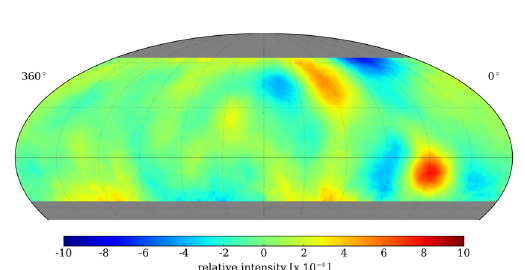
Figure 2: Relative intensity ( bottom ) of the cosmic-ray flux af-ter fit and subtraction of the dipole, quadrupole, and octupole terms from the map shown in above. The map is shown with 10 ◦ smoothing